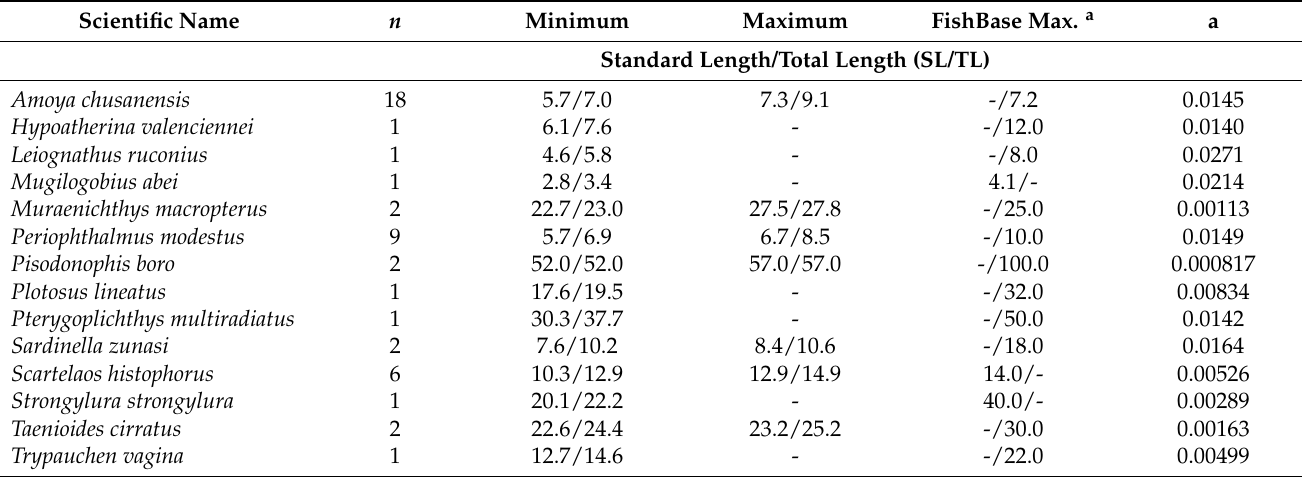
Table 2. Fish species sampled in the mangrove of the Dongzhaigang National Reserve, Hainan Province, China, and for which a sufficient number of specimens, covering a wide range of lengths were not available; the length–weight relationships (LWR) were thus assumed to have the form W = a · L 3 (with L = standard length). All the lengths are in centimeters; n = number of individuals.